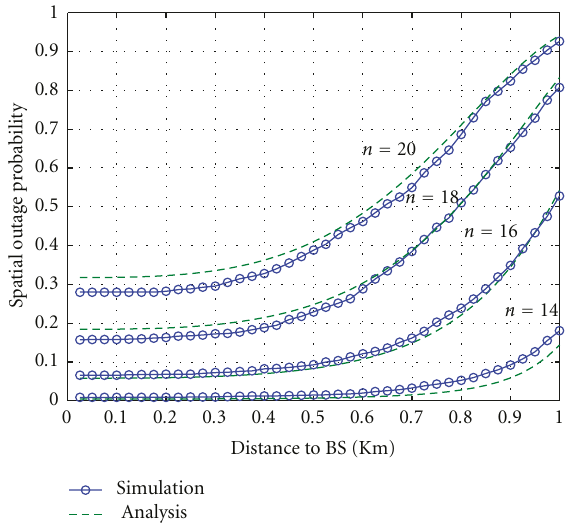
Figure 11: Spatial outage probability as a function of the distance to the BS for various numbers of users per cell and for η =